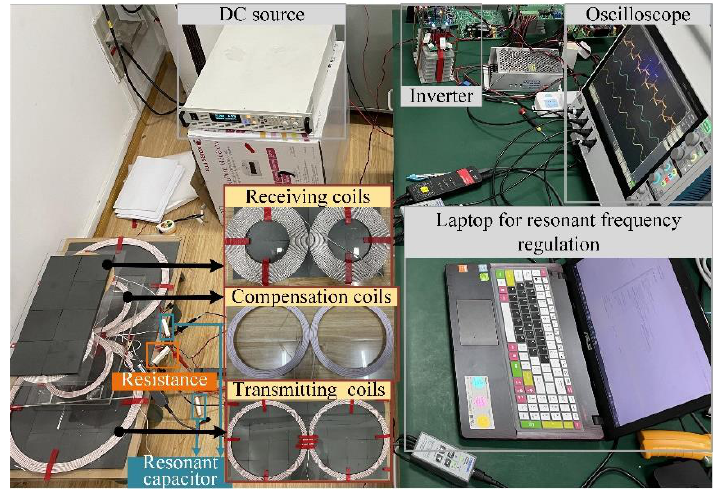
Figure 9. Experimental prototype of the proposed WPT system.